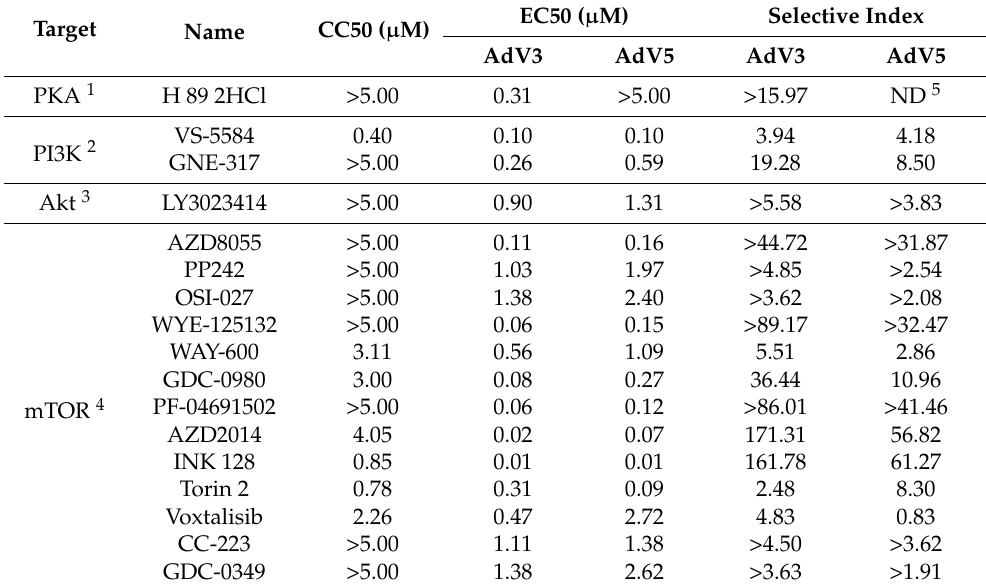
Table 2. Anti-ADV activities of hit compounds targeting PI3K/Akt/mTOR.